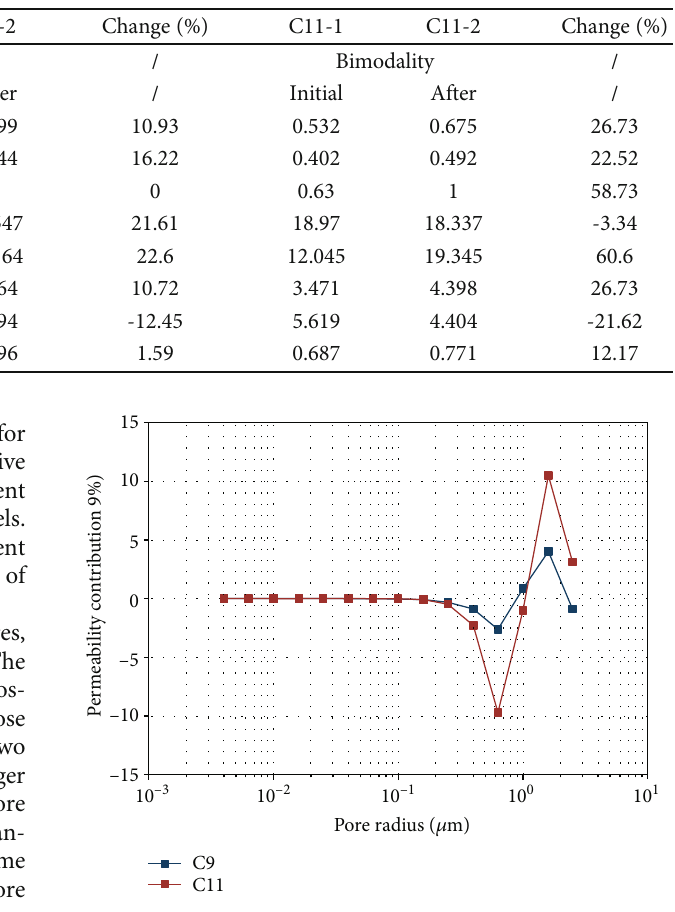
Figure 8: The plot of permeability contribution versus pore